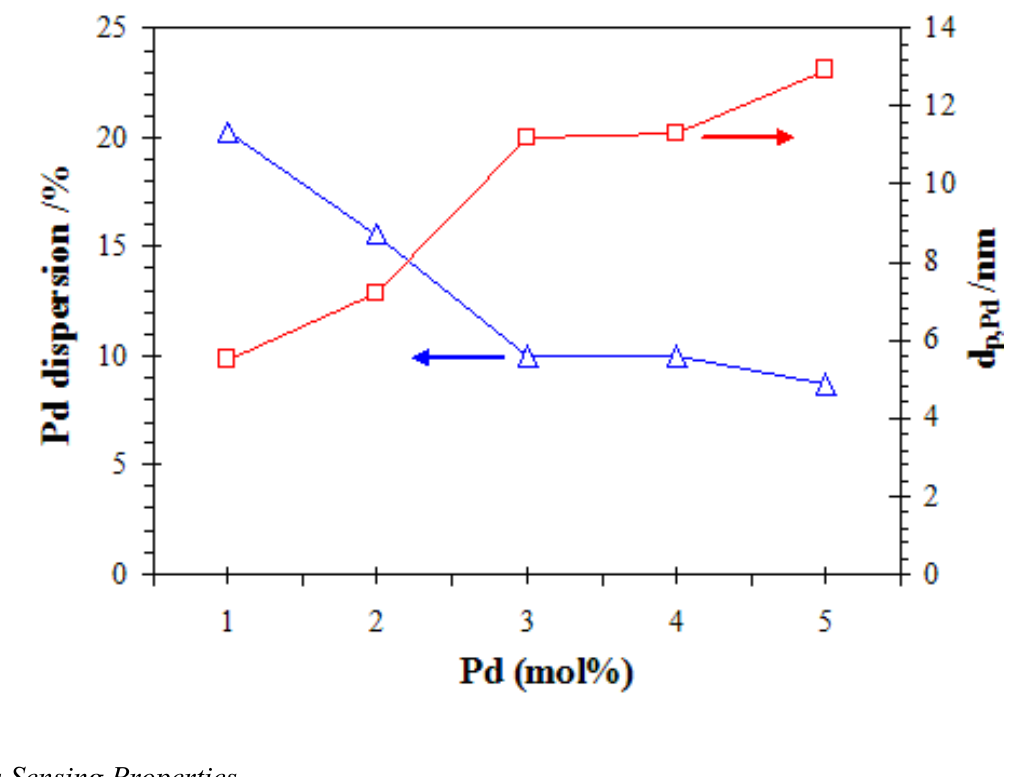
Figure 10. Pd-dispersion and Pd particle diameters as derived from CO-pulse chemisorption as a function of Pd